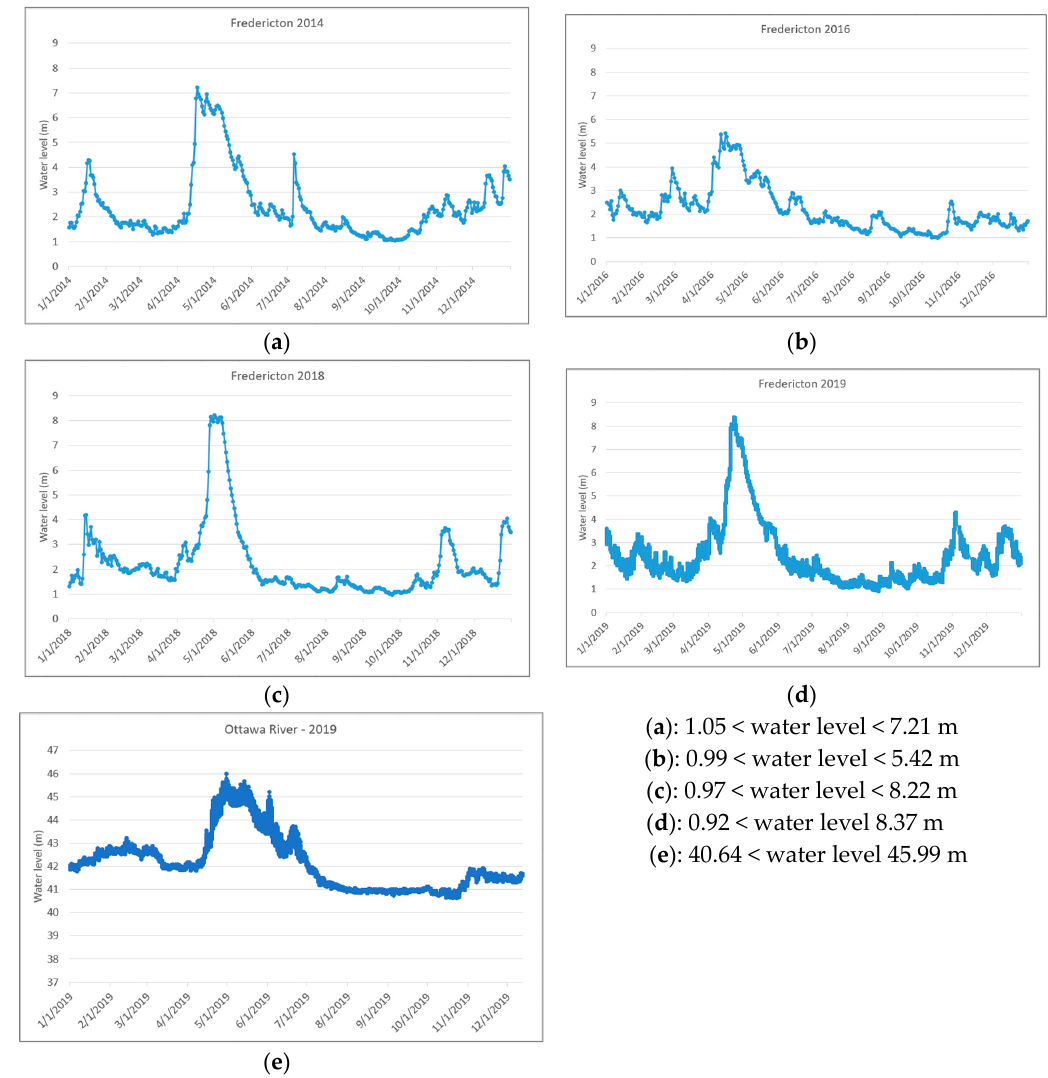
Figure 2. Gauge station readings representing water level for Saint John River in ( a ) 2014, ( b ) 2016, ( c ) 2018, ( d ) 2019 and in Ottawa River in ( e ) 2019.